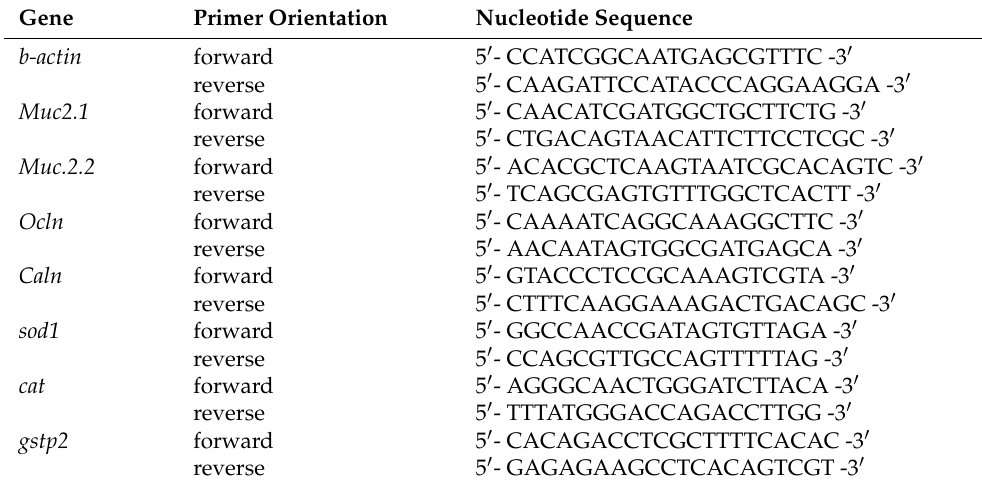
Table 1. Primers for real-time PCR.